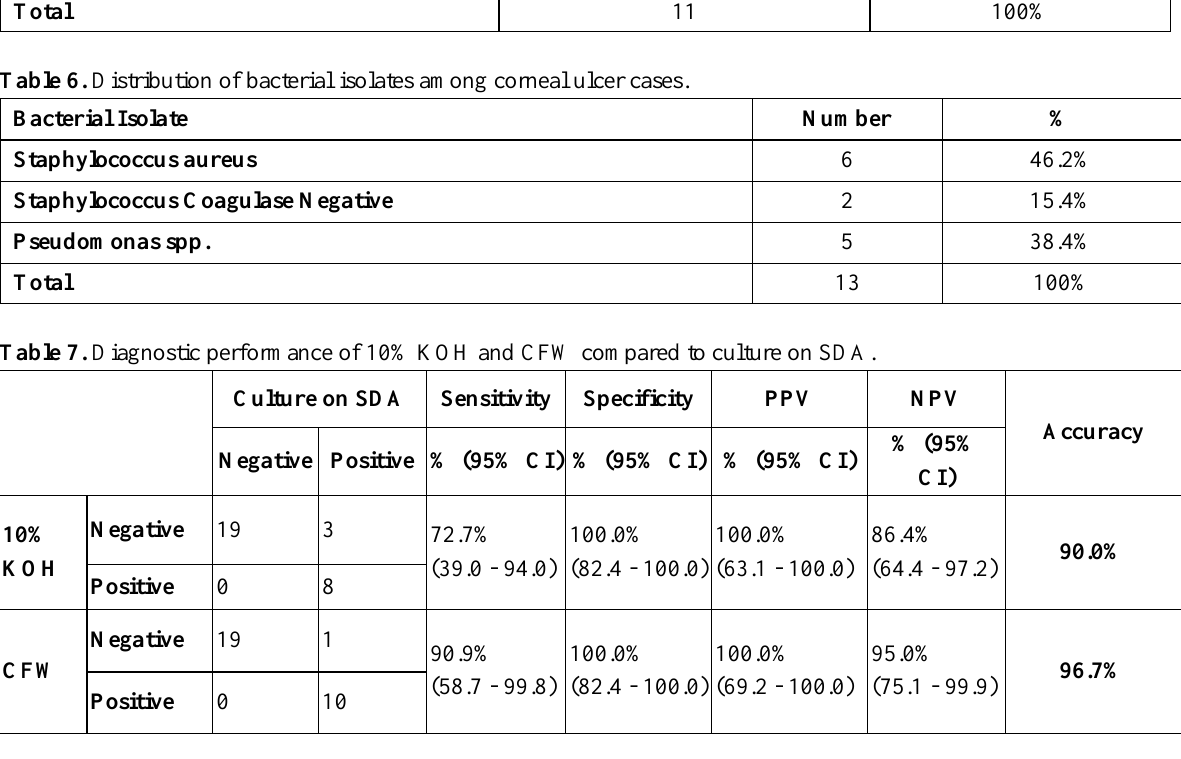
Table 5. Distribution of fungal isolates among corneal ulcer cases. Fungal Isolate Fusarium spp. Aspergillus spp. Candida spp Penicillium spp. Alternaria spp.